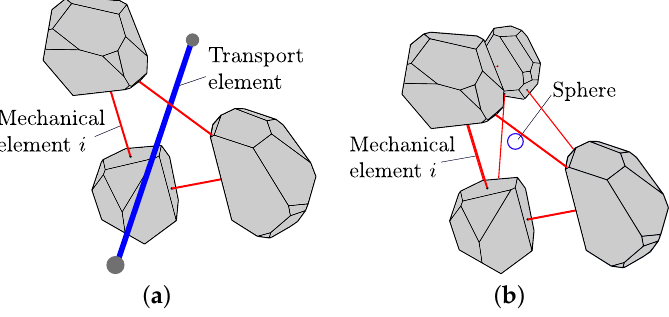
Figure 5. Coupling between structural and transport network: influence of plastic strains on ( a ) the pipes and ( b ) the